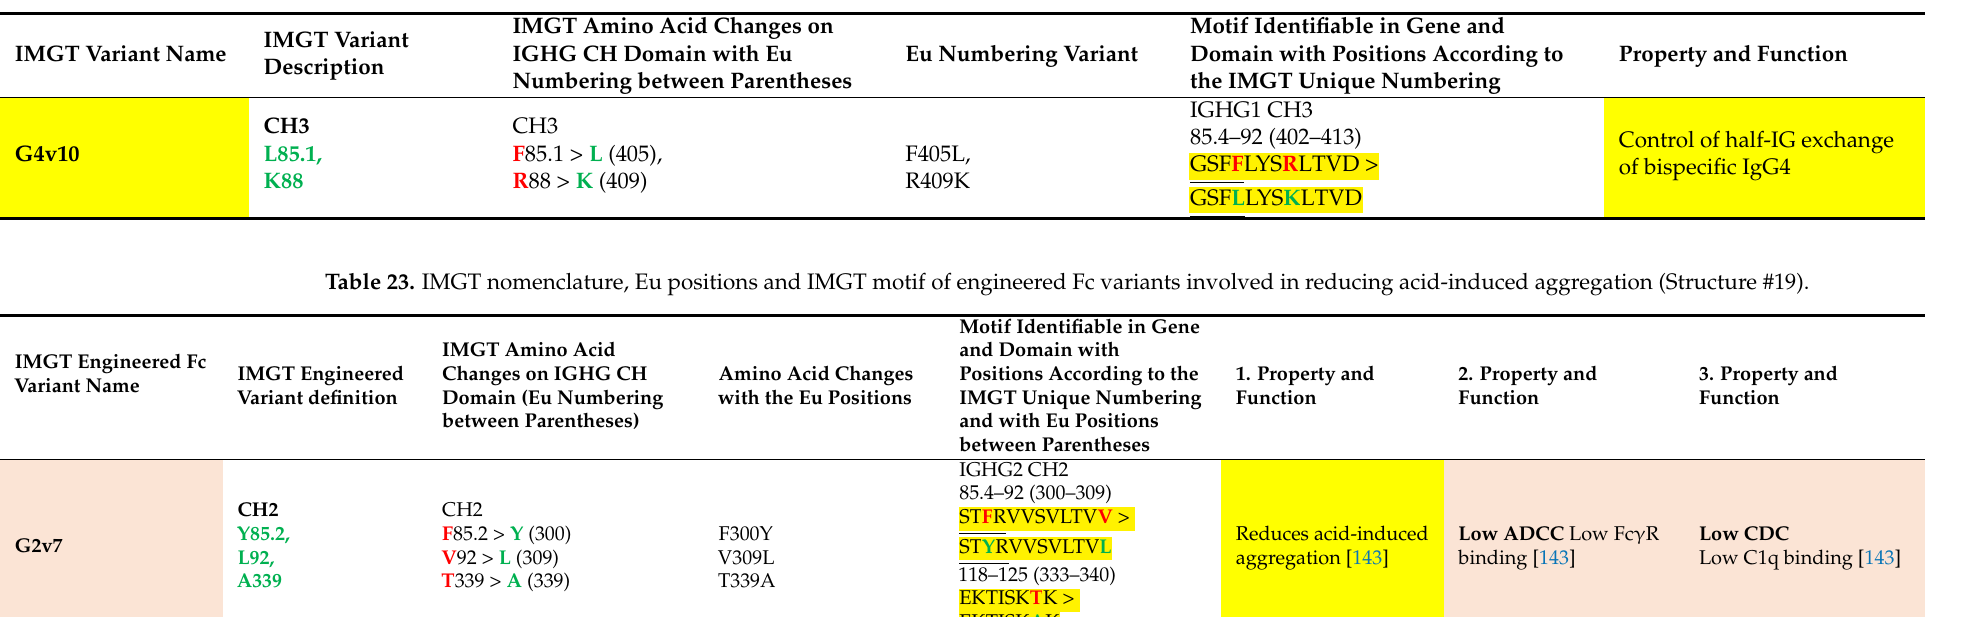
Table 22. IMGT nomenclature, Eu positions and IMGT motif of engineered Fc variants involved in the control of half-IG exchange of bispecific IgG4 (Structure #18).